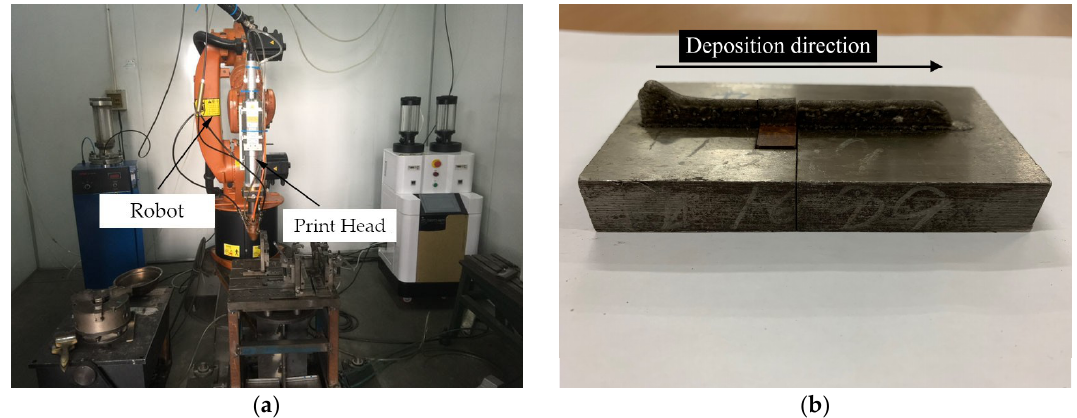
Figure 1. Pictures of the cladding equipment and specimens: ( a ) cladding equipment; ( b ) picture of one specimen.